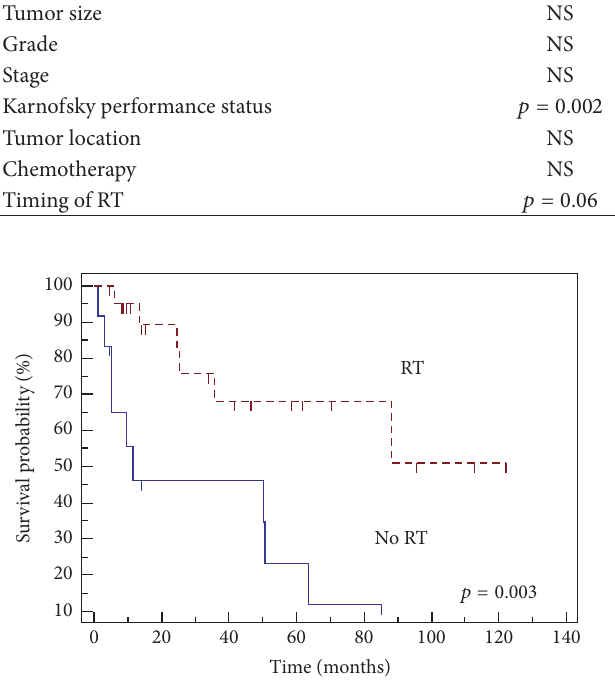
Figure 2: Progression-free survival with and without radiation.